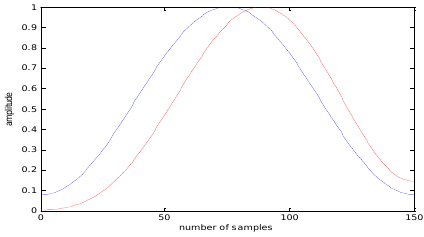
Figure 3. Hamming window ( ---- ) and modified hamming window